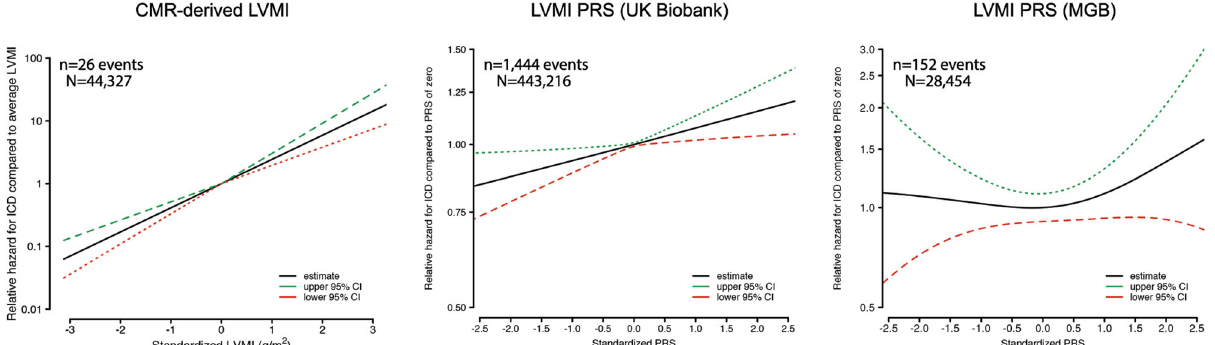
models adjusted for age and sex (left), and adjusted for age, sex, and the fi rst fi ve principalcomponentsofgeneticancestry(middleandright).Therelativehazardis plotted on the logarithmic scale. The functional form of the association was selected empirically using a penalized spline approach, in which the degrees of freedom for the penalized spline fi t were chosen based on minimization of the corrected Akaike Information Criterion 75 . The number of events and individuals included in each analysis are listed above each plot.